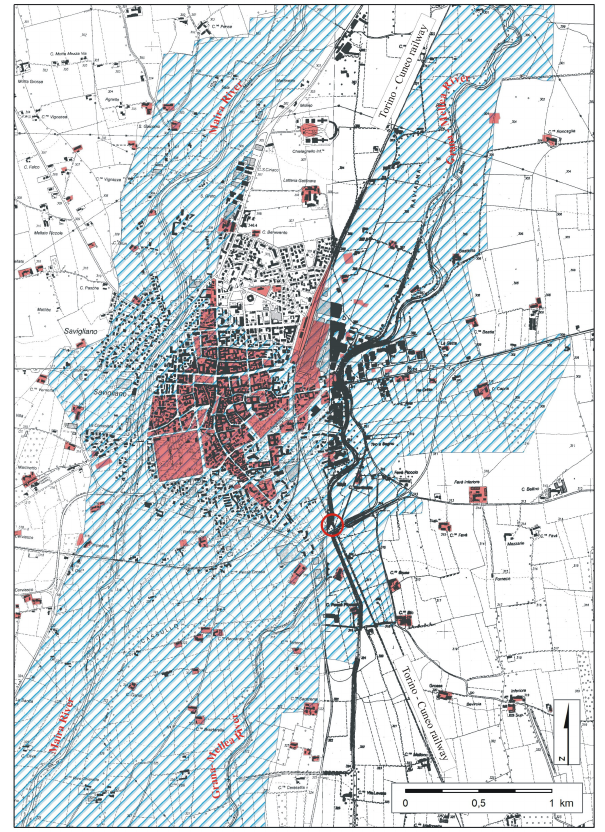
Fig. 2. Area affected by the 1896 flood (oblique blue lines). The red colour represents the city at the time (derived by the 1879 map edition): all the city was involved in flood. In the red circle the Torino-Cuneo railway bridge on Grana-Mellea River is indicated. In the background the Technical Regional map, 1991 edition.